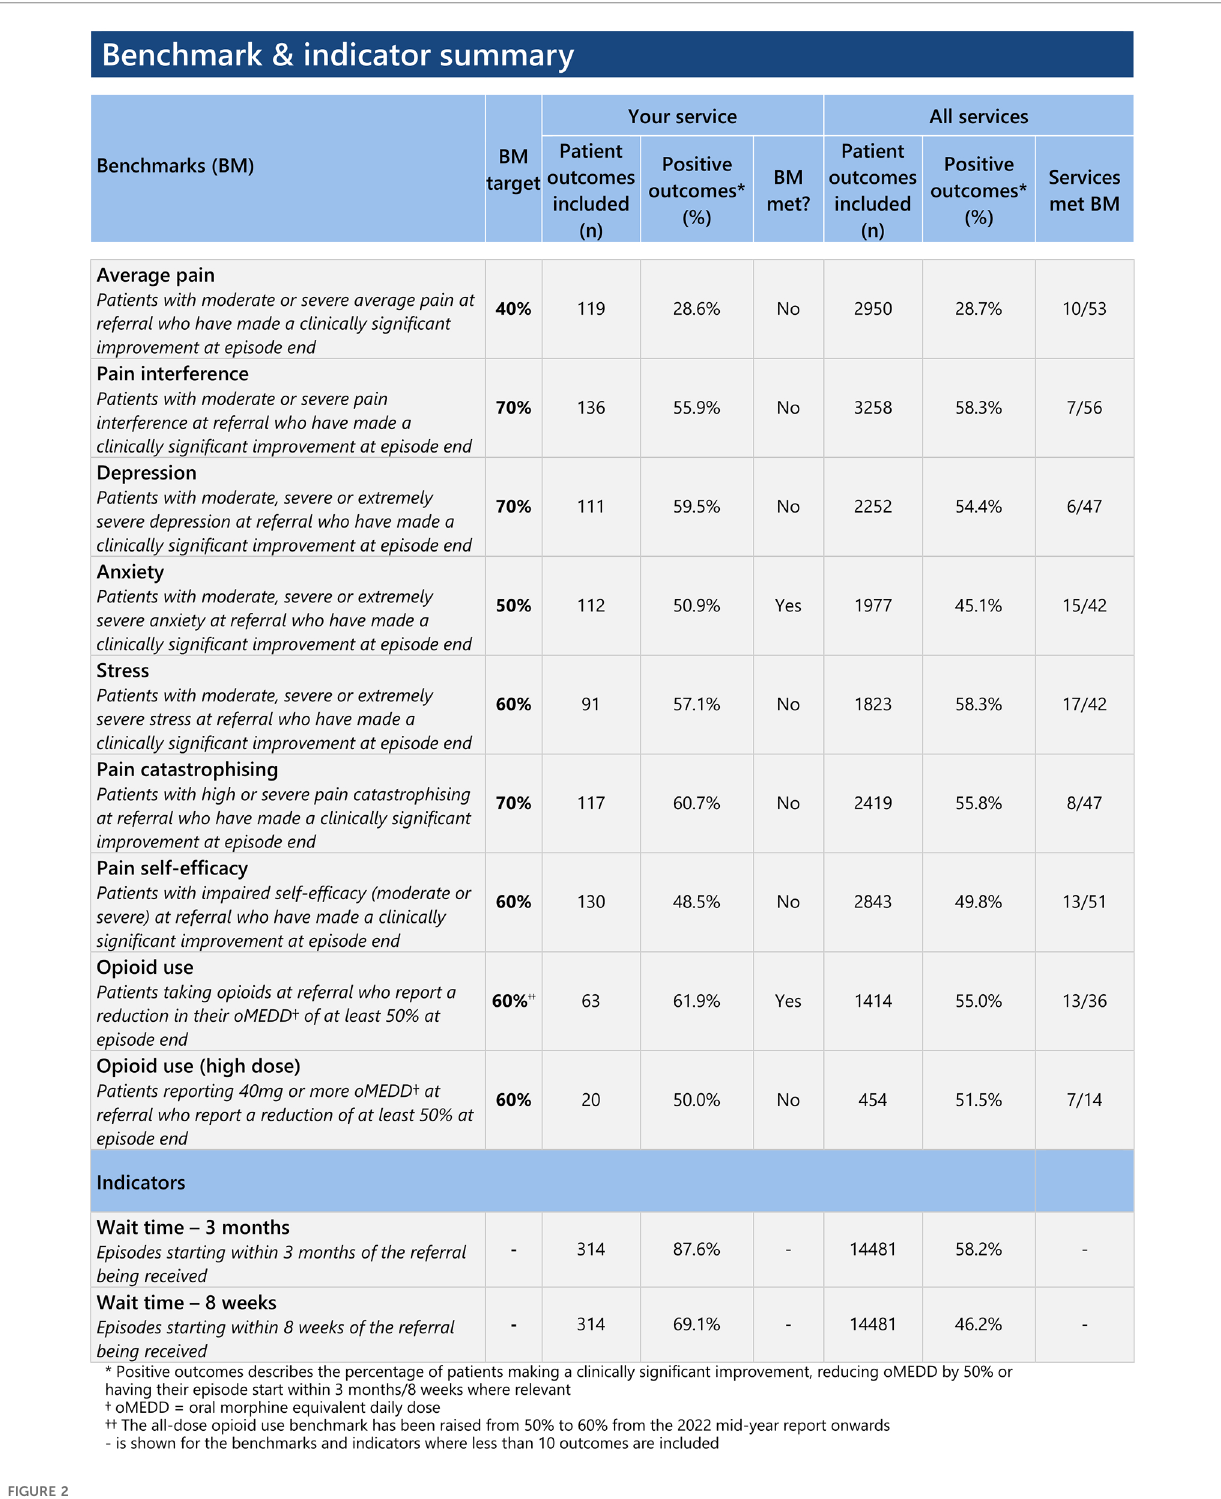
FIGURE 2 Clinical outcomes by domain, total patient cohort